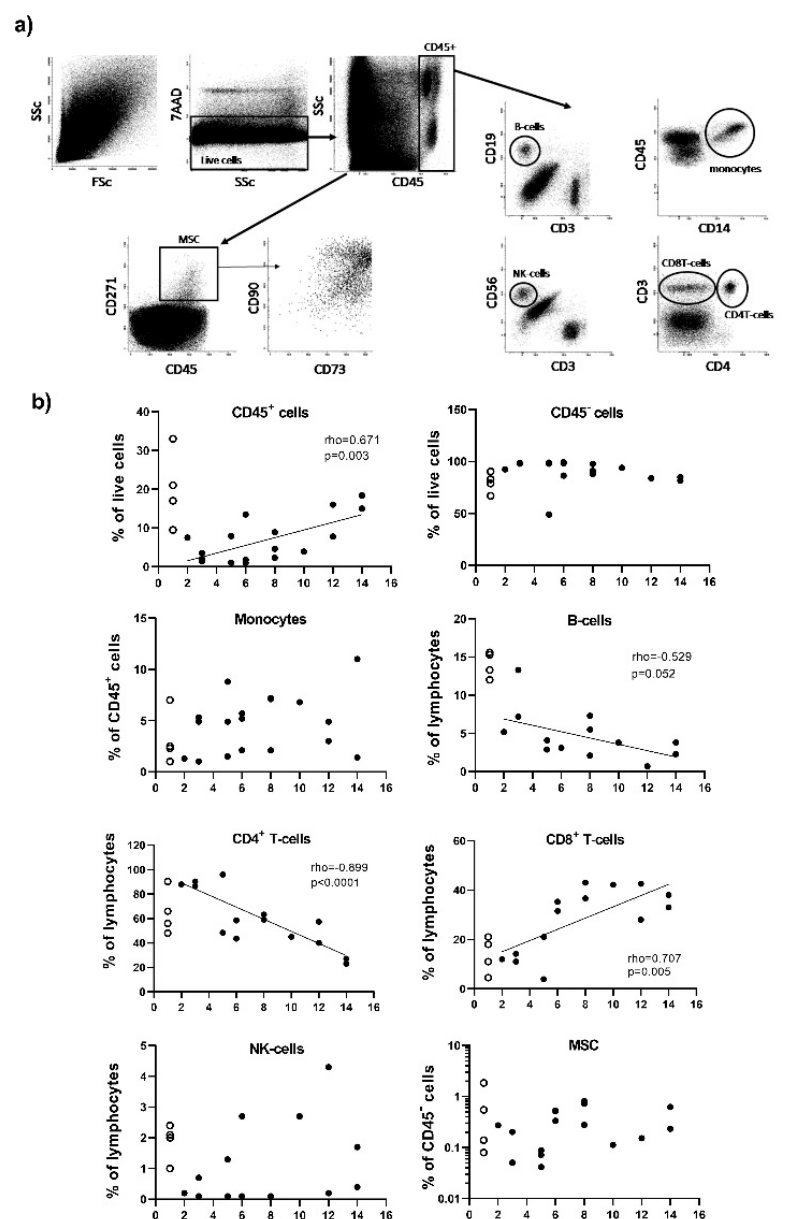
Figure 6. Flow cytometry analysis of the cells present in healthy bone and at the fracture site. ( a ) Flow cytometry gating strategy. In total, 100,000 events were recorded (1st plot FSc/SSc). Live cells were initially gated as 7AAD- events (2nd plot: SSc/7AAD). Doublet exclusion was performed (not displayed in figure). CD45+ and CD45– cells were then gated from the 3rd plot: (CD45/SSc). MSCs were then gated from the CD45- cell population using the expression of CD271 (plot CD45/CD271), also being CD90 and CD73 double positive (plot CD73/CD90 gated on CD271+ cells). Monocytes were directly gated from the CD45+ cells using a CD14/CD45 plot. Lymphocytes were gated from the CD45+ cells using 4 cell surface marker CD3, CD4, CD19 and CD56. Subsets of lymphocytes were identified as T-cells (CD3+CD4+ and CD3+CD4-), B-cell (CD19+) and NK-cells (CD56+). Total lymphocytes weres then calculated as the sum of events for each subset and each subset was reported as a % of total lymphocyte events. ( b ) Plots displaying frequency of cells with respect to time after trauma. Patients SG ( n = 15) are represented by closed symbols and healthy bone HCG ( n = 4) by open symbols (displayed at day 1 for convenience). Correlation with time were established for the fracture samples only (rho values displayed on the plot).